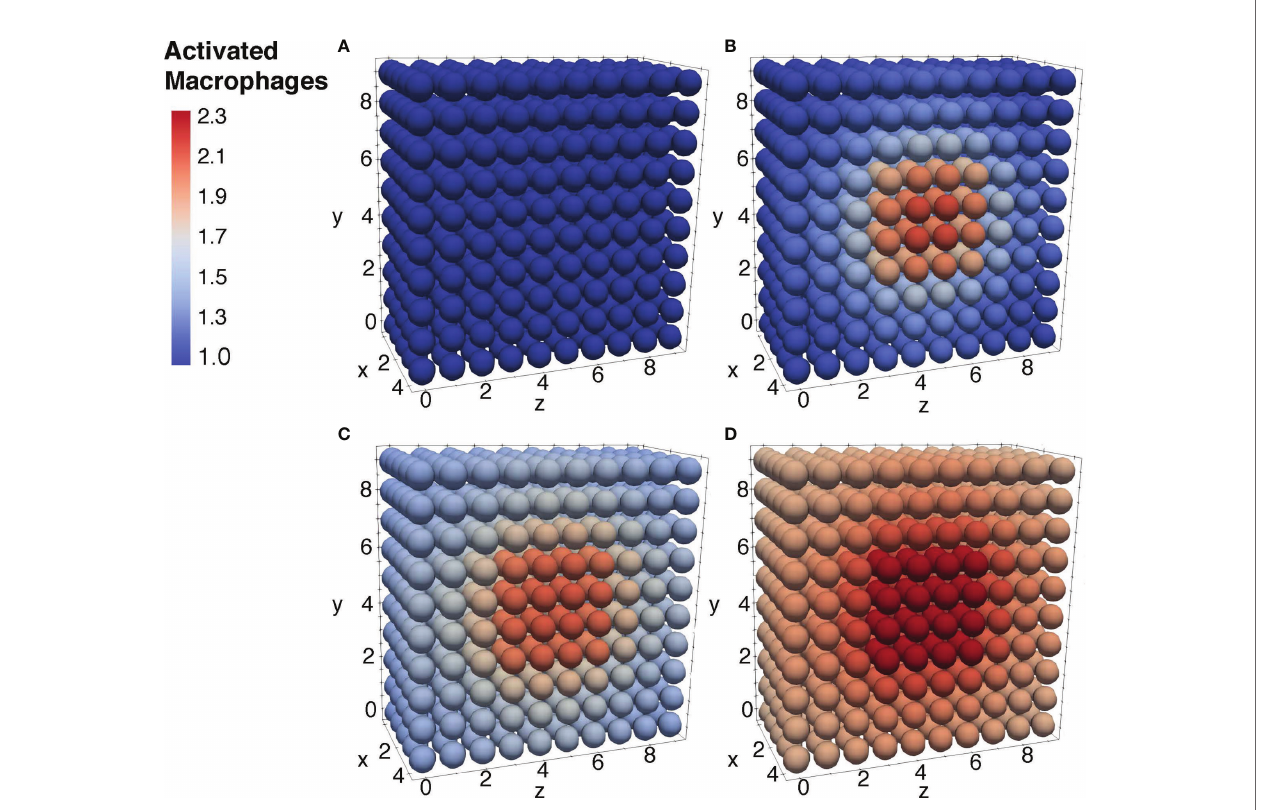
FIGURE 10 | Diffusion of the activated macrophages at different time periods. Initial condition of the resting macrophages (A) , after 3h of simulation where the values increase as a result of change of state from resting to activated (B) , after 12h of simulation (C) , and after 24h of simulation (D)